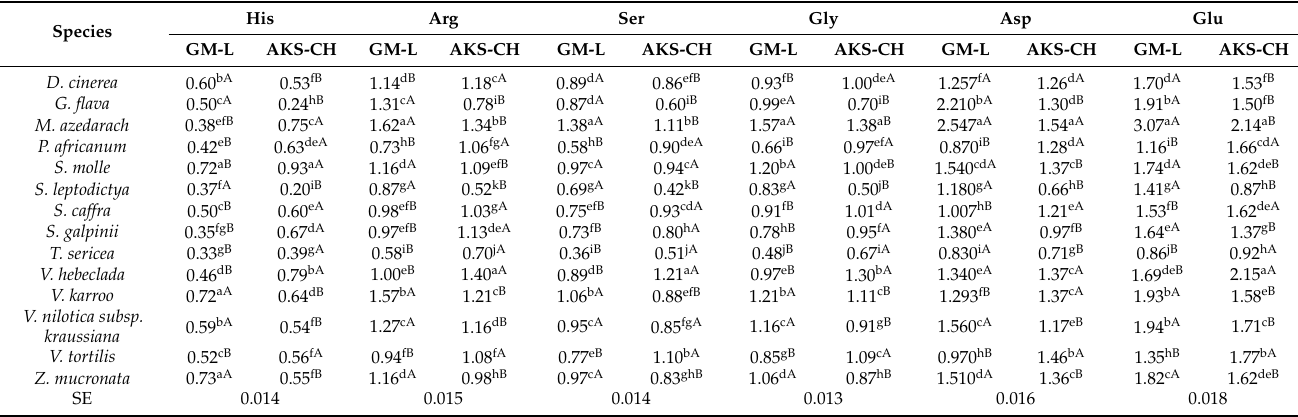
Table 5. Effect of species and soil type on His, Arg, Ser, Gly, Asp and Glu (g/100 g sample) of browse species found in GM-L and AKS-CH soil types.